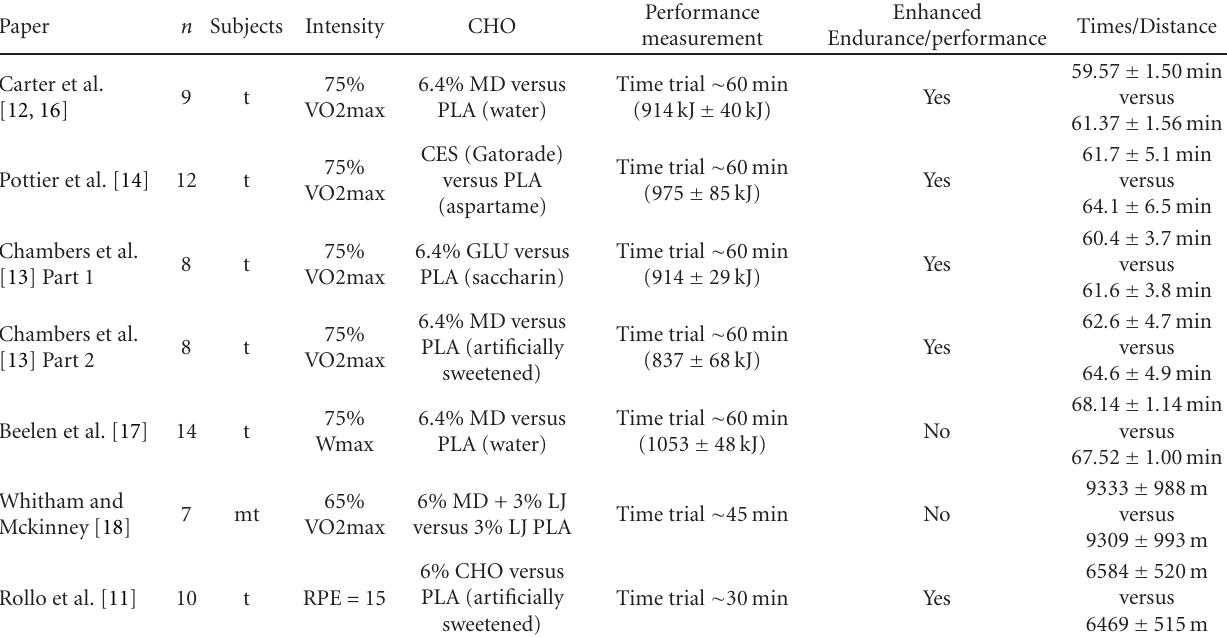
Table 2: Summary of studies investigating the e ff ects of a carbohydrate mouth rinse solution on high intensity exercise. Paper n Subjects Intensity